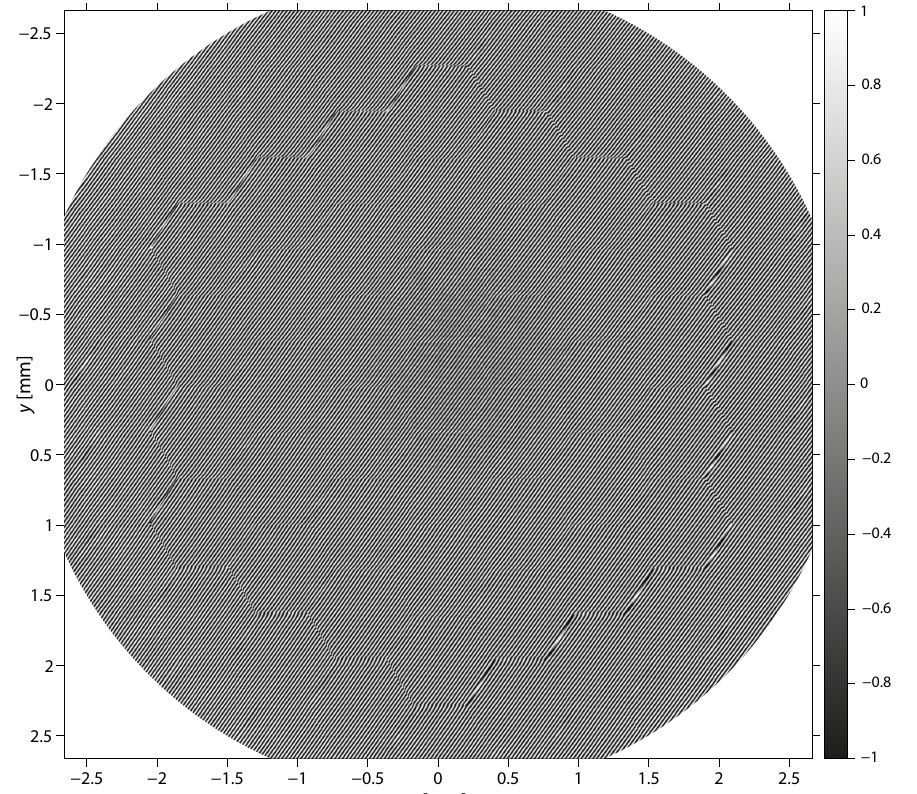
Figure 3. Interferogram of the deformable mirror in its full extent with corners excluded from further